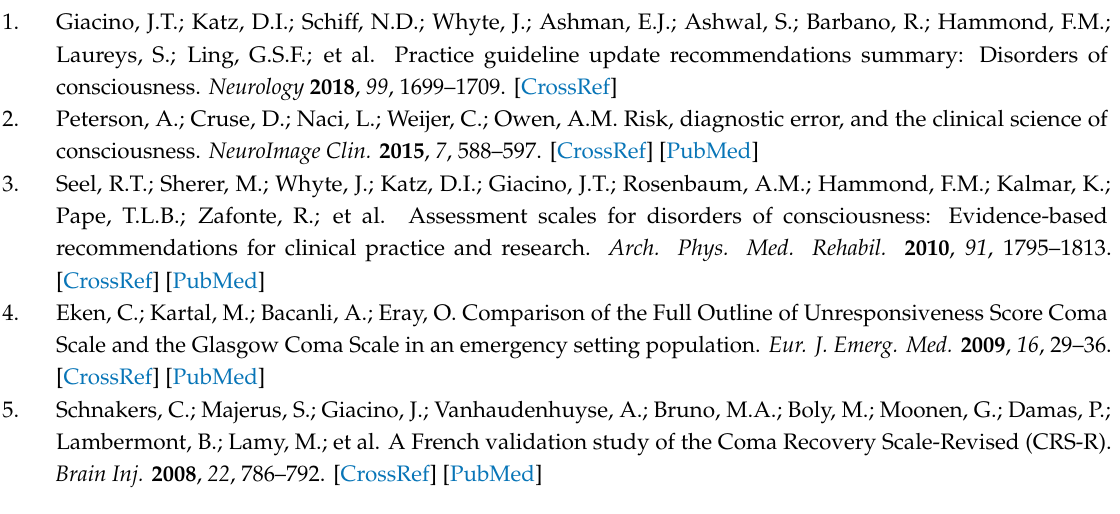
Table S1: Clinical and demographic characteristics of the sub-sample of patients having both CNCS and LOCFAS assessments, three and six months after injury. Table includes data divided by etiology, Table S2: Frequencies and percent distribution of the patients’ scores into the CNCS and LOCFAS levels at T0 and at T1. Results refer to patients older than 48 months ( n = 54), Table S3: Frequencies and percent distribution of the patients’ scores into the CNCS levels at T0 and at T1. Results refer to patients younger than 48 months ( n = 38), Table S4: Frequencies and percent distribution of the patients’ scores into the CNCS levels at T0 and at T1. Results refer to the whole sample ( n = 92), Table S5: Scores for 11 single CNCS items at T0 and T1 (reported as median and mode), and results of the comparison of each item at T0 vs. T1. Results refer to the whole sample ( n = 92), Table S6: Scores for 10 single LOCFAS domains at T0 and T1 (reported as median and mode), and results of the comparison of each item at T0 vs. T1. Results refer to patients older than 48 months ( n = 54), Table S7: Scores for 10 single LOCFAS domains at T0 and T1 (reported as median and mode), and results of the comparison of each item at T0 vs. T1. Results refer to samples with TBI ( n = 37) and NTBI ( n =